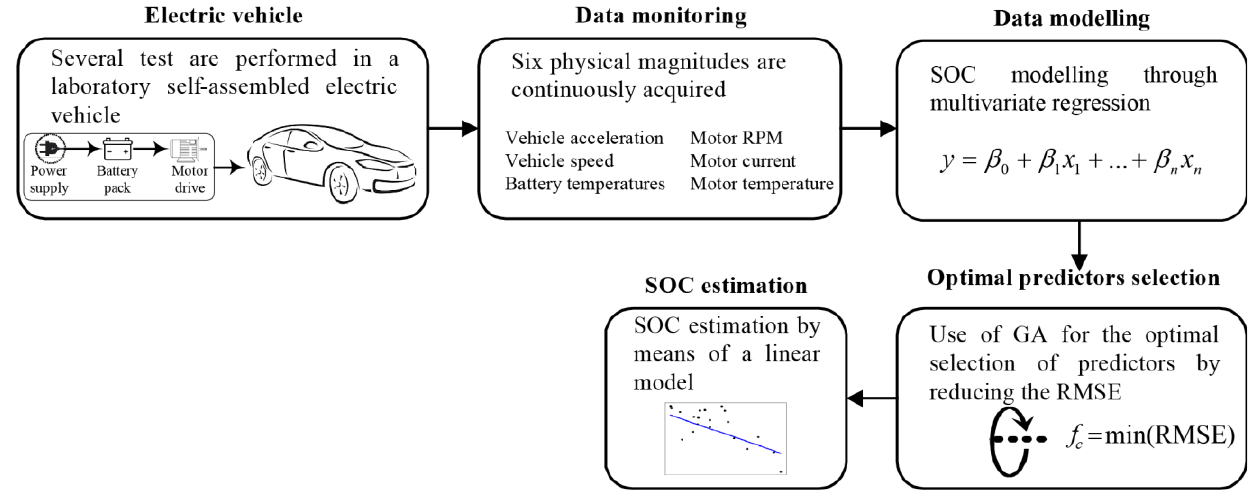
Figure 2. Flow chart of the proposed methodology based on a multivariate regression approach and GA for estimating the SOC of an electric vehicle.